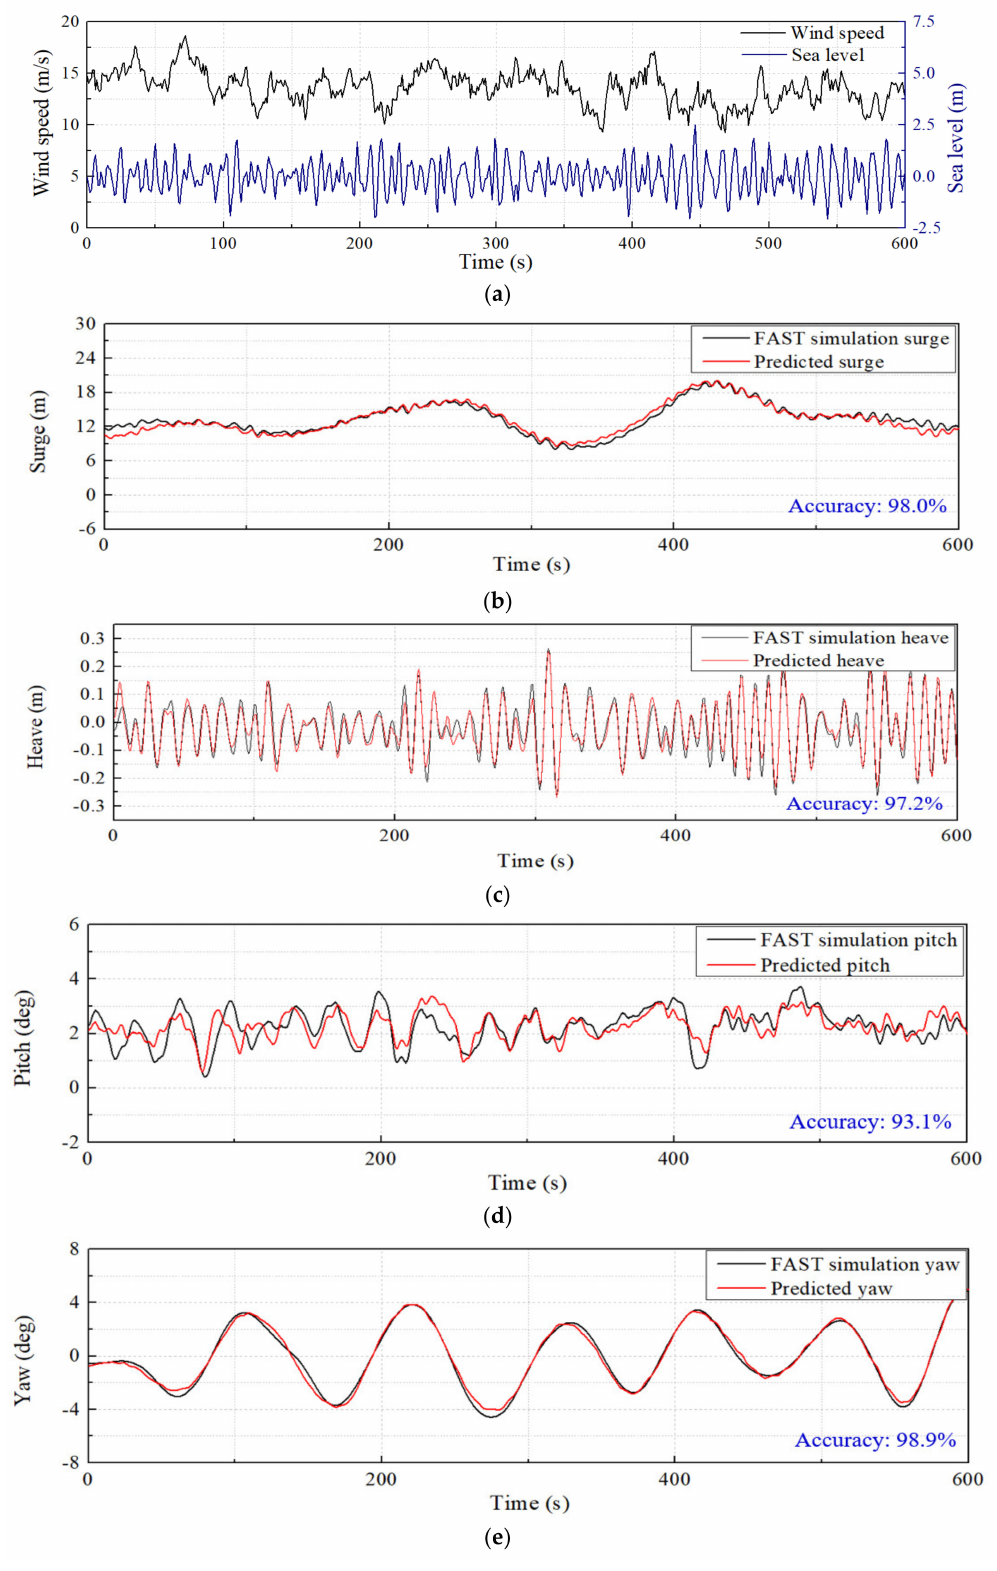
Figure 6. Accuracy and training results of the ROM system for the 4-dof, ( a ) Input data for prediction of 4-dof, ( b ) predicted surge, ( c ) heave, ( d ) pitch, and ( e )